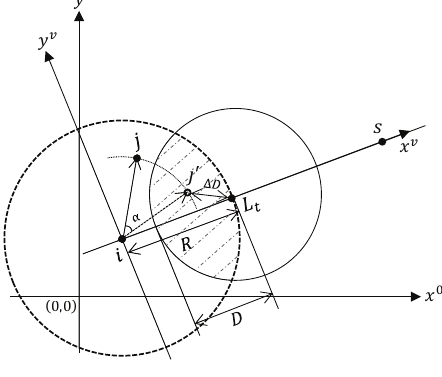
Figure 8. Next Hop Selection in